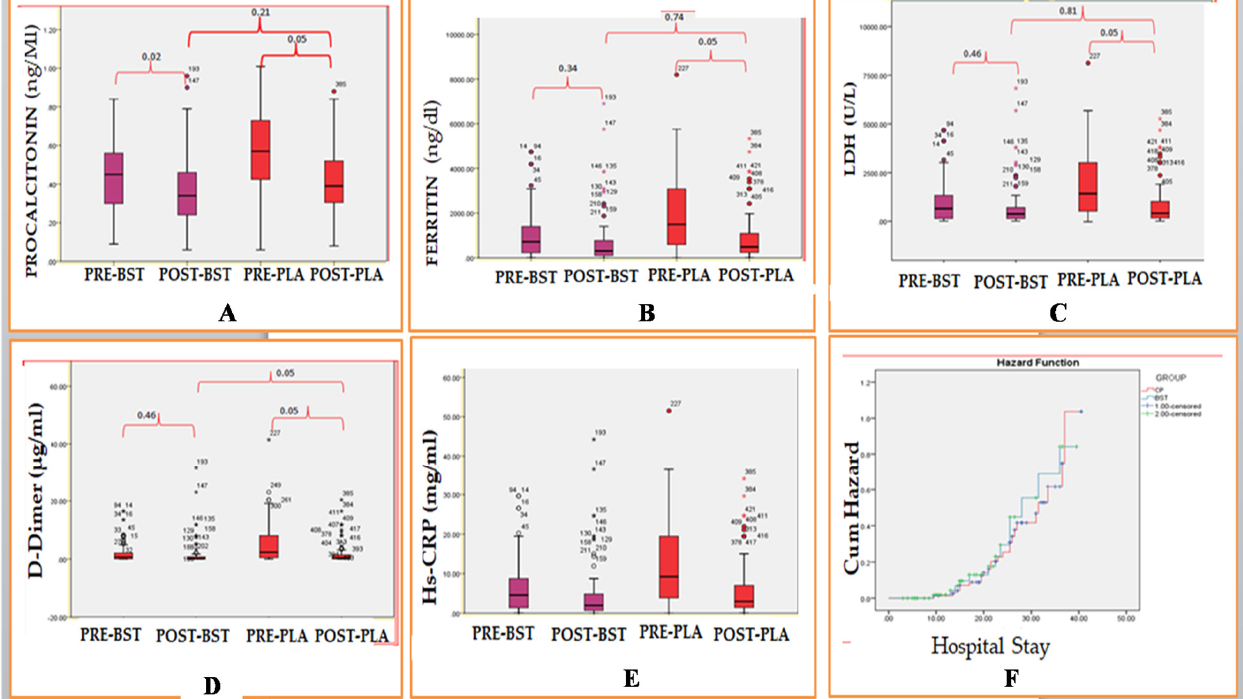
Figure 1. ( A – E ) Dynamic changes of Hs-CRP, D-dimer, LDH, ferritin, and procalcitonin during hospitalization and the horizontal lines represent the median value in each group. ( F ) Kaplan–Meier analysis showing hazard in CP and BST group.